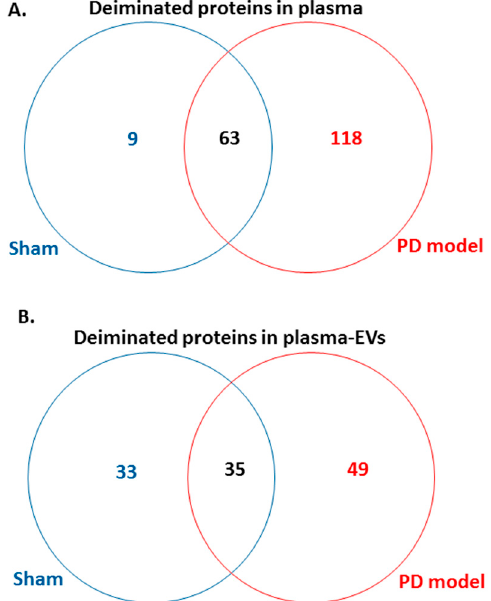
Figure 5. Venn diagram showing deiminated protein hits identified in plasma and plasma-EVs of pre-motor PD model and of sham rats. ( A ) A considerable higher number of deiminated protein hits was identified in plasma of the pre-motor PD model rats, compared with that in shams, with some overlapping protein hits. ( B ) A higher number of protein hits was identified to be deiminated in circulating plasma-EVs of the pre-motor PD rat models, compared with that in shams, with some hits